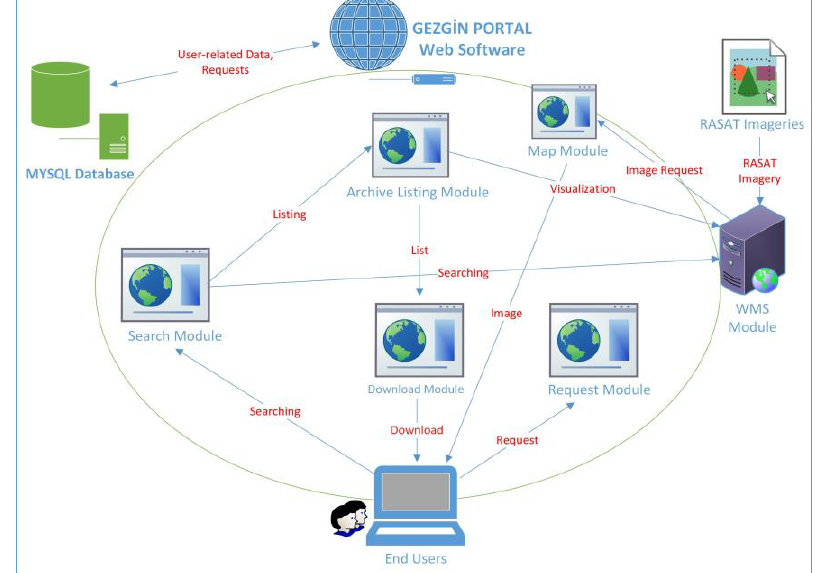
Figure 10. GEZGIN system